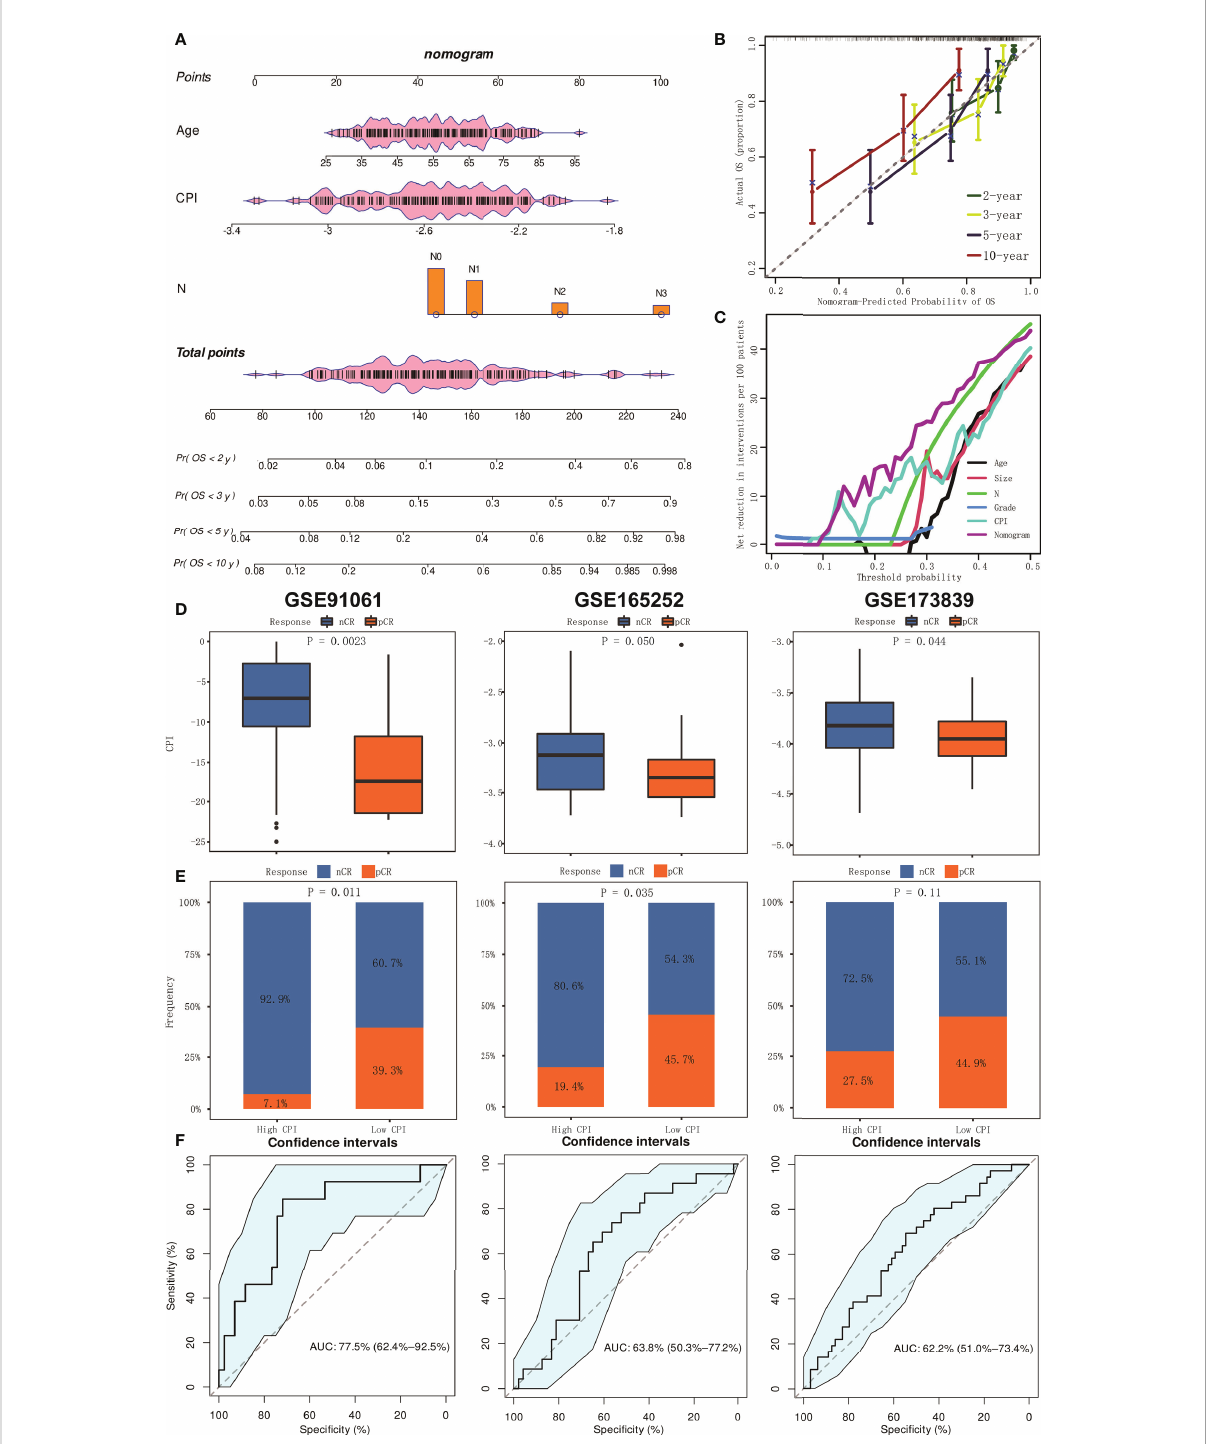
FIGURE 7 The establishment and assessment of the nomogram and prediction of immunotherapy responsiveness. (A) Nomogram based on clinical features and CPI. (B) Calibration curves in predicting the 2-, 3-, 5-, and 10-year survival rate. (C) DCA of nomogram comparing age, tumor size, pathologic N, grade, and CPI. (D) Boxplots of the values of CPI between pCR and nCR groups in GSE91061, GSE165252, and GSE173938 cohorts. (E) Results of chi-square test between responsiveness and CPI groups in GSE91061, GSE165252, and GSE173938 cohorts. (F) ROC curve analysis of predicting the immunotherapy responsiveness in GSE91061, GSE165252, and GSE173938